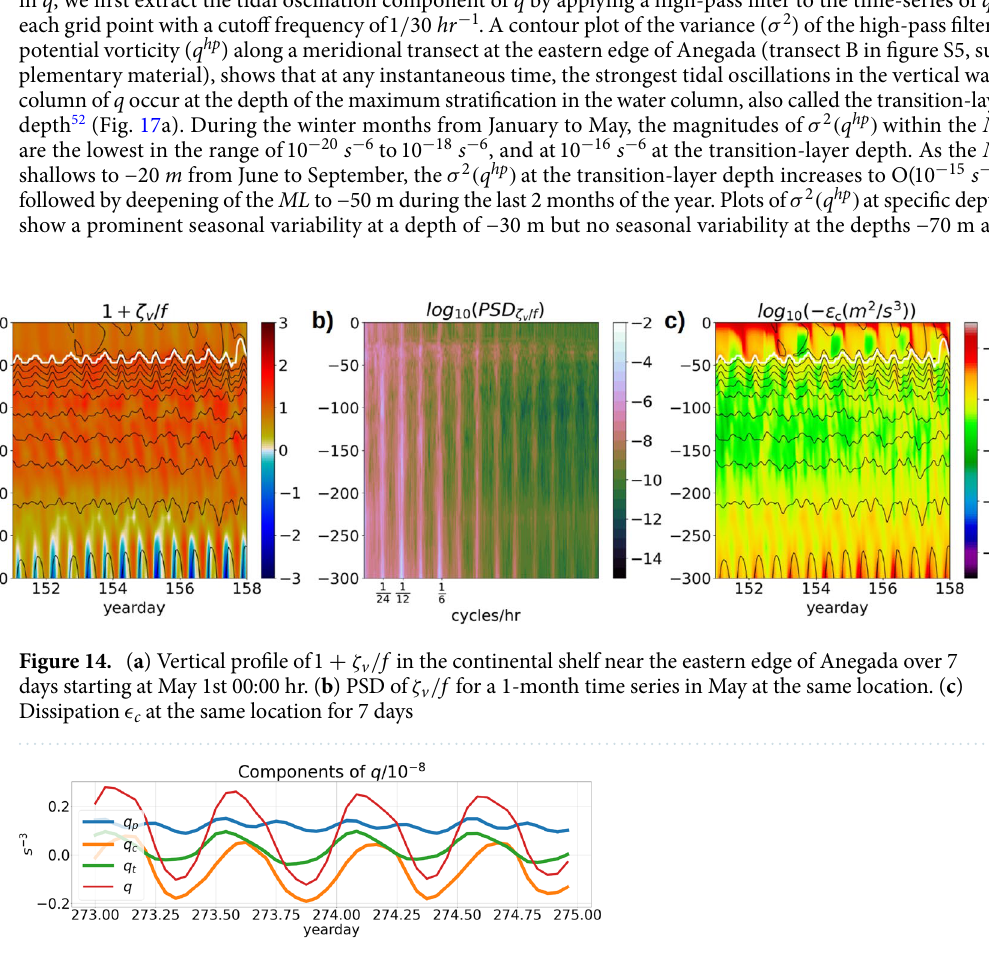
Figure 15. Time-series of the components of q at the first σ surface in the continental shelf near the eastern edge of Anegada (depth −300